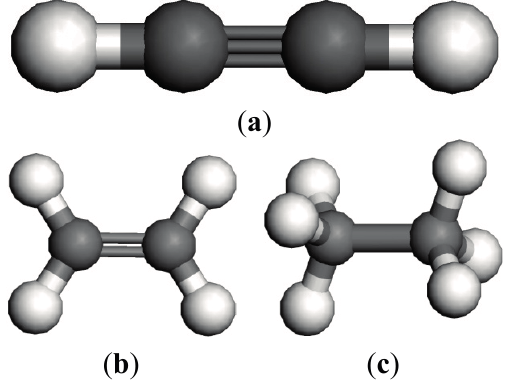
Figure 7. Structural model of oil-dissolved gases. ( a ) C 2 H 2 ; ( b ) C 2 H 4 ; ( c ) C 2 H 6